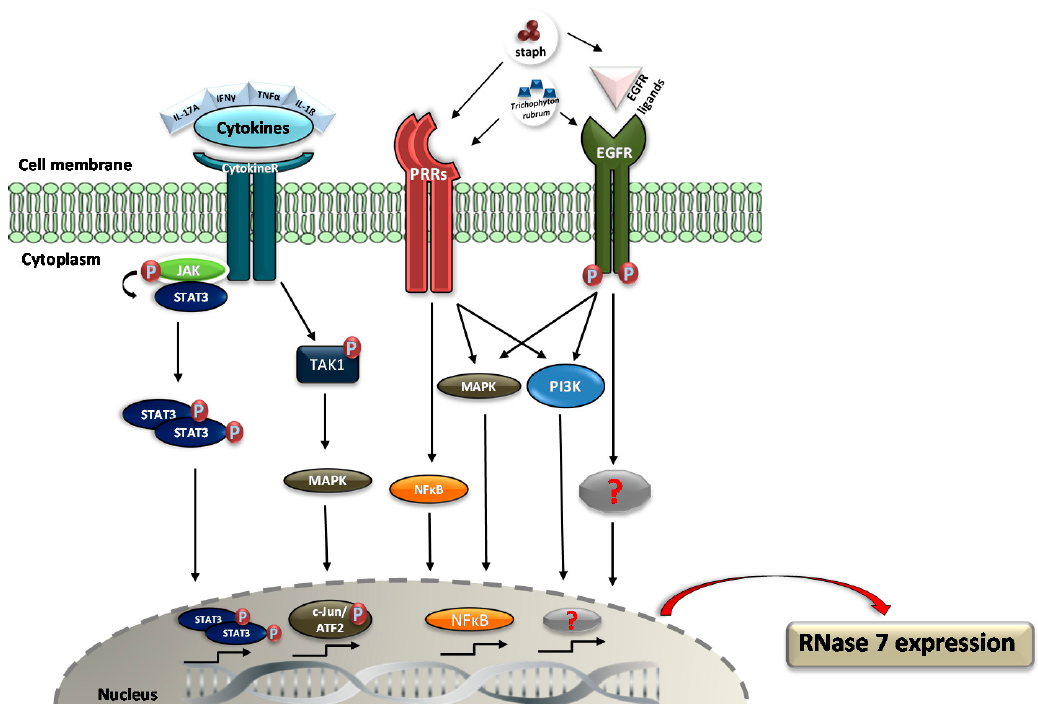
Figure 2. Regulation of RNase 7 induction. Mohammed et al. [38] reported that RNase 7 expression induced by IL-1 β in human corneal epithelial cells is regulated by phosphorylation of transforming growth factor β -activated kinase-1 (TAK1) and subsequent activation of mitogen-activated protein kinase (MAPK) pathway leading to activation of the transcription factors c-Jun and ATF2. Simanski et al. [39] demonstrated that IL-17A/IFN γ -induced RNase 7 expression in keratinocytes is mediated via STAT3 signaling. Wanke et al. [41] reported that Staphylococcus -mediated RNASE7 induction is regulated via two different pathways. Staphylococcus epidermidis activates TLR-2 and a signaling cascade involving activation of the EGFR by EGFR ligands as well as activation of the transcription factor NF κ B. Staphylococcus aureus activates the mitogen-activated protein kinase and phosphatidylinositol 3-kinase (PI3K)/AKT signaling pathways. Firat et al. [14] documented that EGFR signaling is involved in Trichophyton rubrum -induced RNase 7 expression in keratinocytes. (PRRs = pattern recognition receptors; black arrows = activation; red curved arrow = induction; red “P” = phosphorylated).